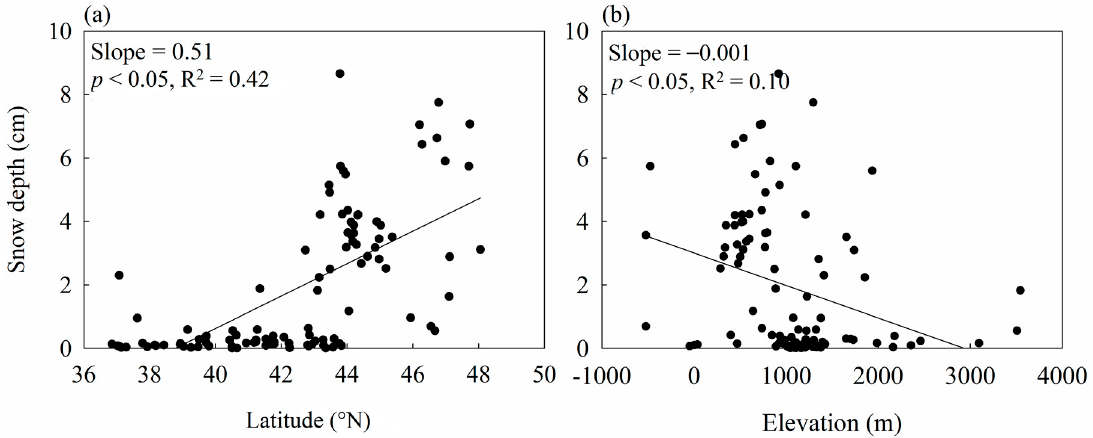
Figure 14. Relationship between annual snow depth (cm) and latitude ( a ), elevation ( b ) for all stations over 1961–2015 in Xinjiang.